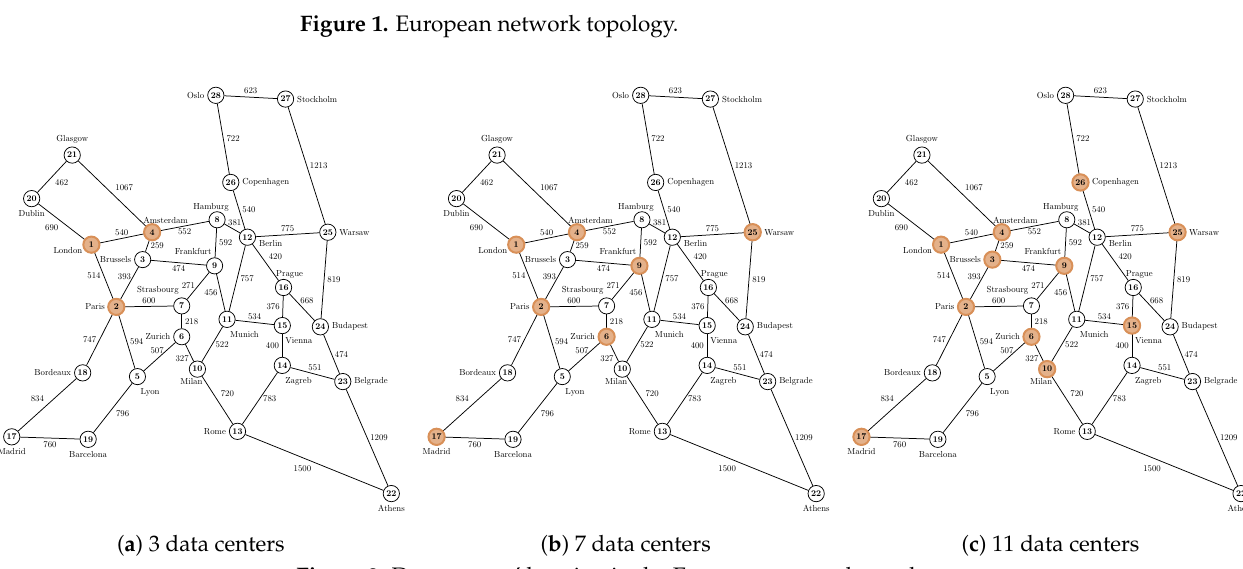
Figure 2. Data centers’ location in the European network